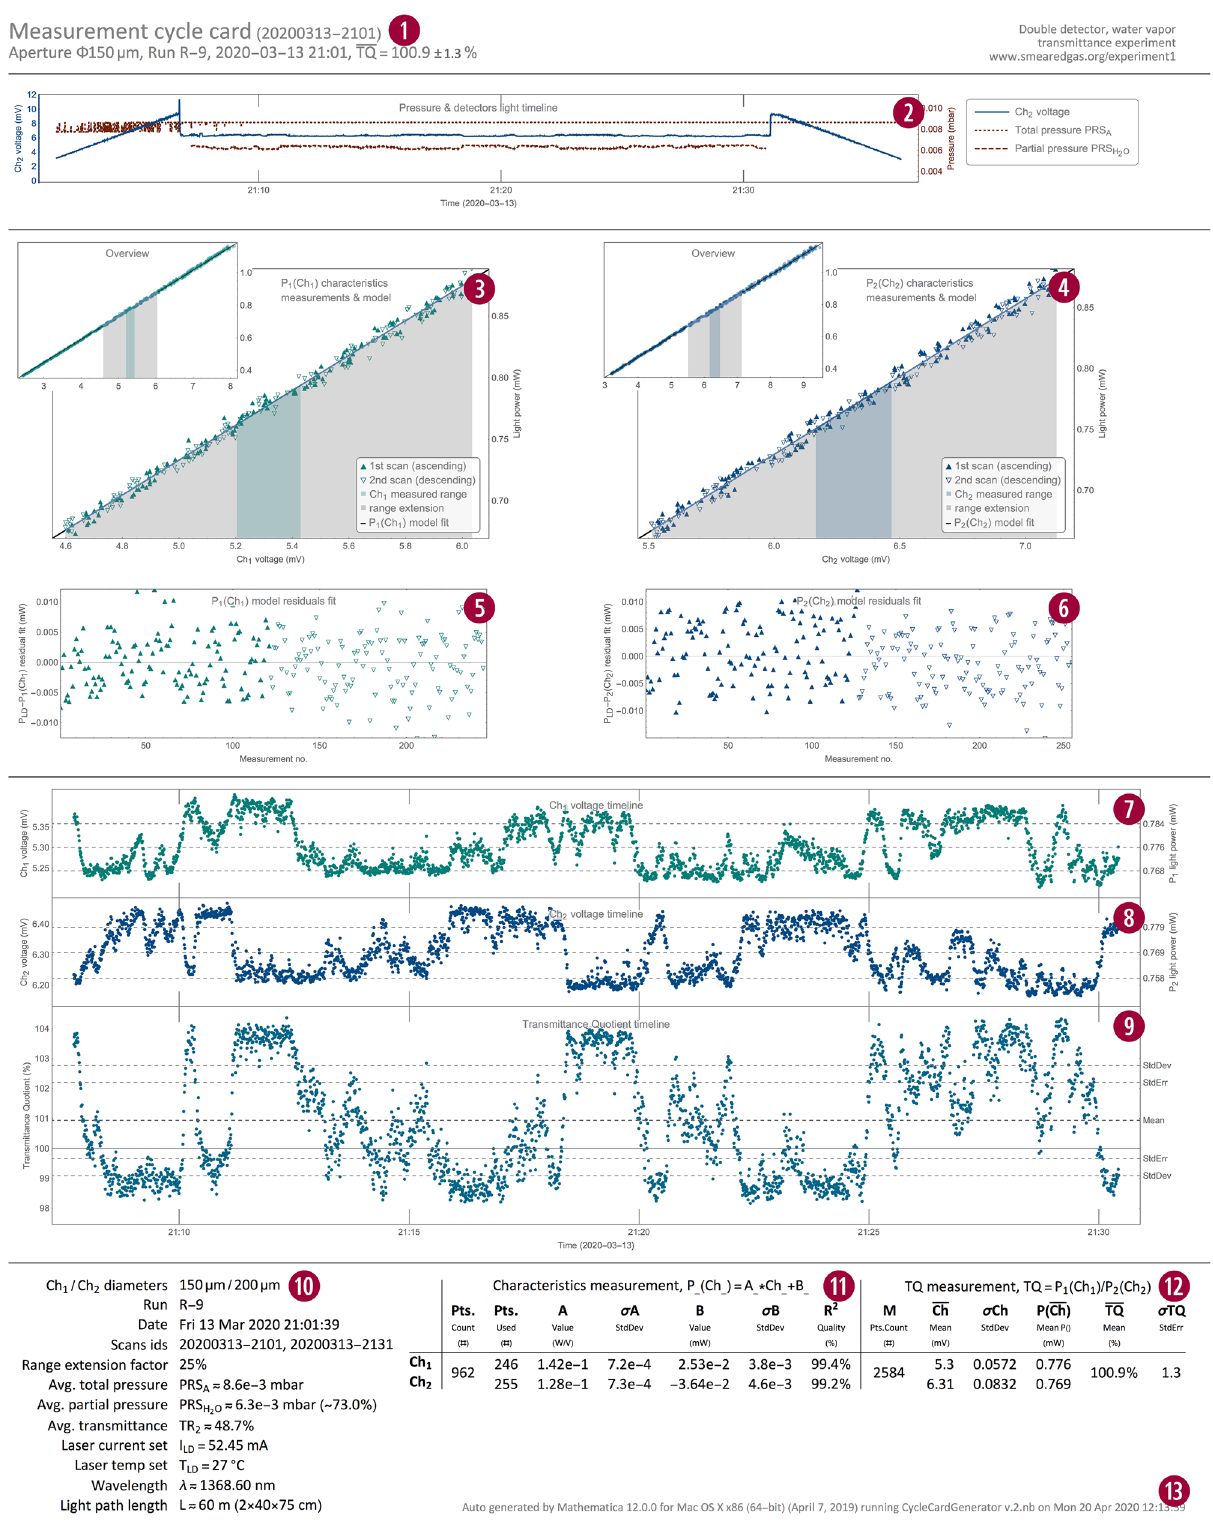
Figure 10. All measurements taken during the cycle are shown on a sample cycle card. The numbers in the circles refer to the sections descriptions in the